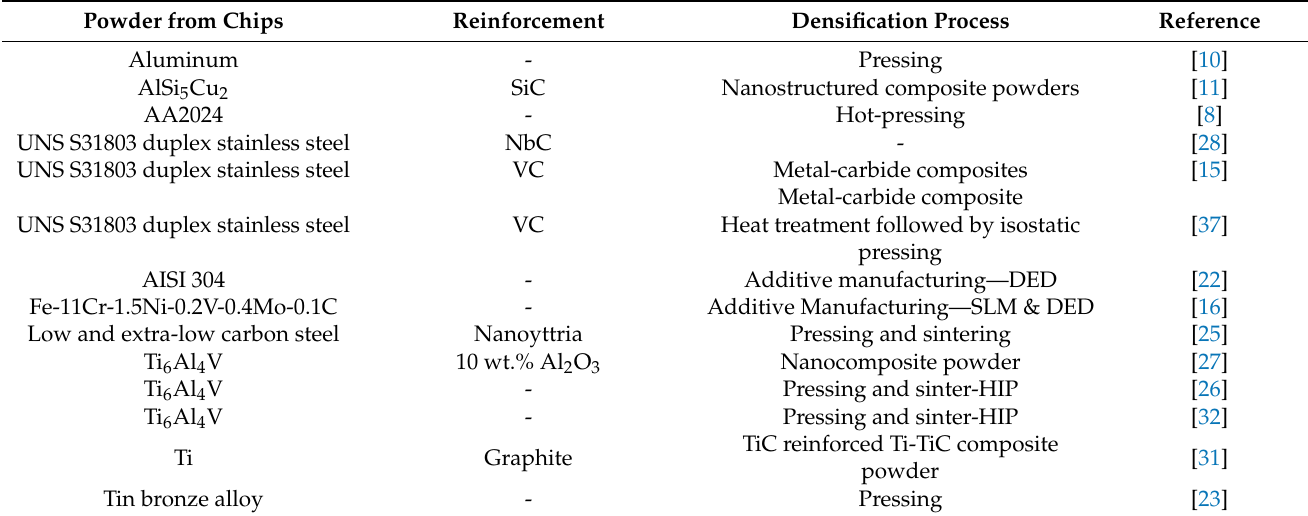
Table 5. Applications of milled